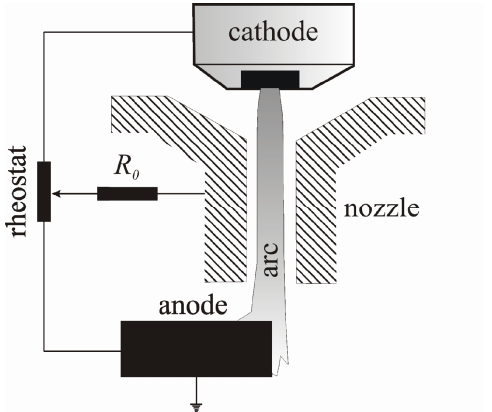
Figure 1: Schematic of the nozzle biasing circuit.